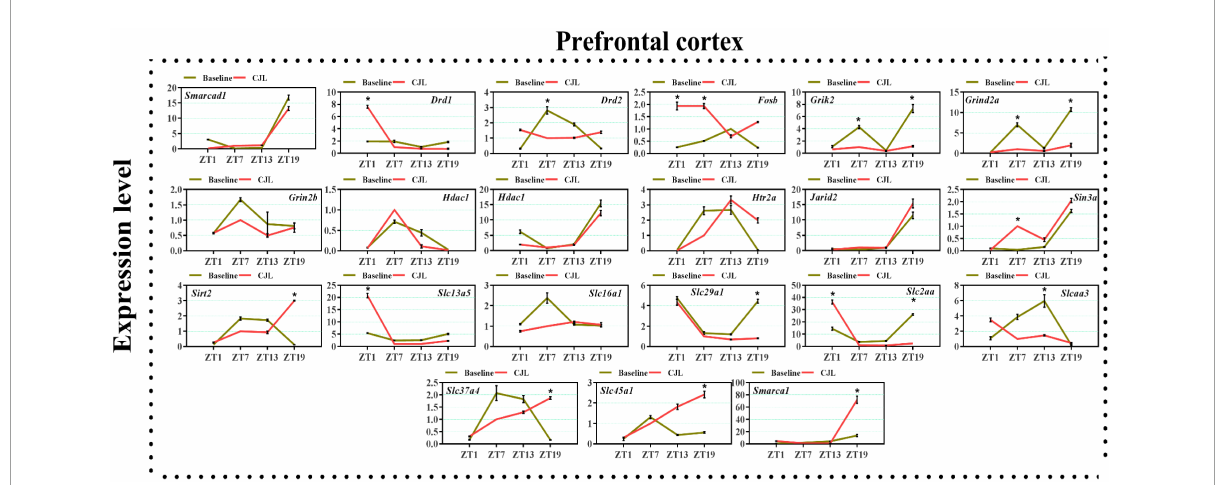
FIGURE3 Chronic jetlag (CJL) altered mRNA levels of genes associated with psychiatric disorders in the PFC. This figure shows mRNA levels in PFC extracts from baseline and CJL treated animals ( n = 3 per group), as assayed by three independent qPCR assays, at four different time points (ZT1, ZT7, ZT13, and ZT19). Results are expressed as mean ± SEM. * P < 0.01, two-way ANOVA.